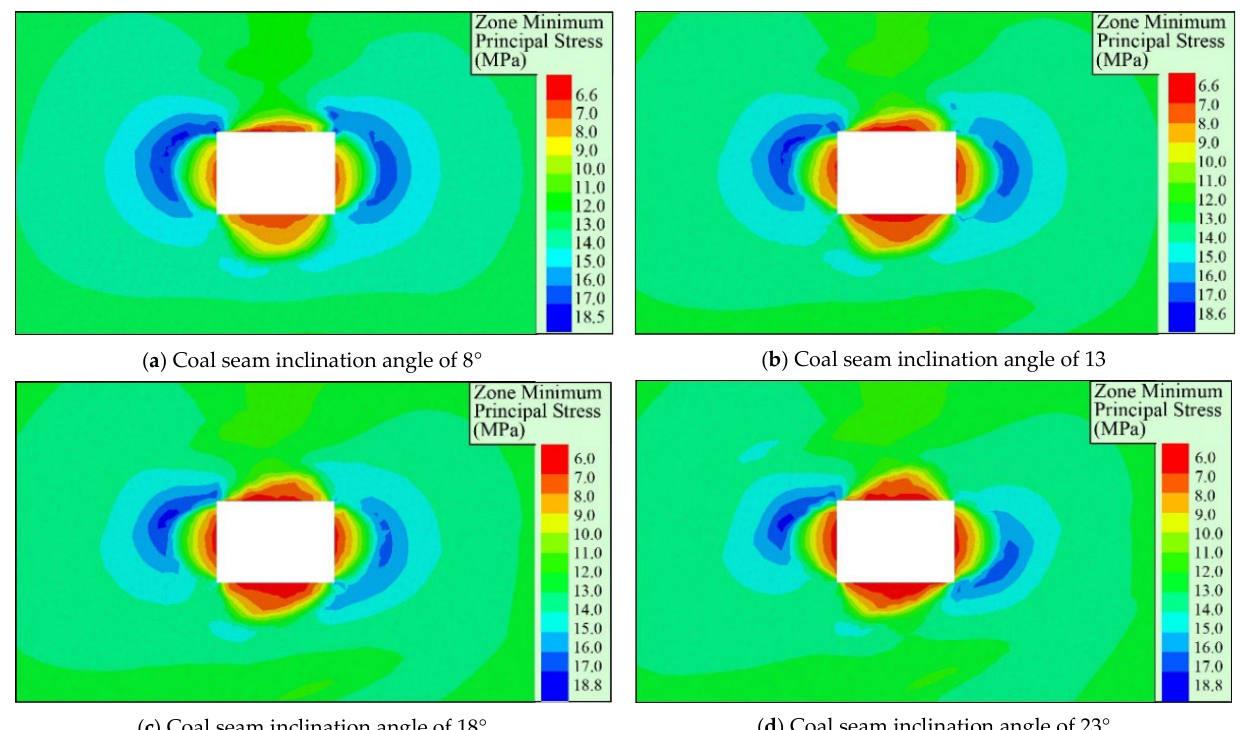
Figure 11. Distribution of minimum regional stress.